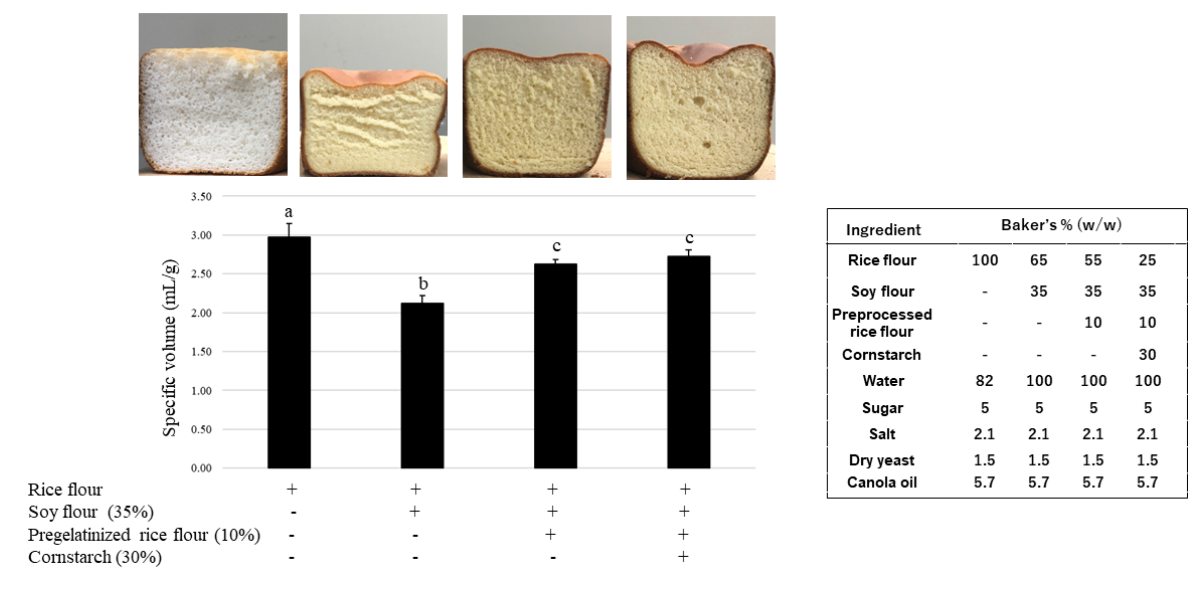
Figure 3. ( A ) Effect of pregelatinized rice flour substitution amount on specific volume; ( B ) Recipes for soy rice bread with preprocessed rice flour and cornstarch.